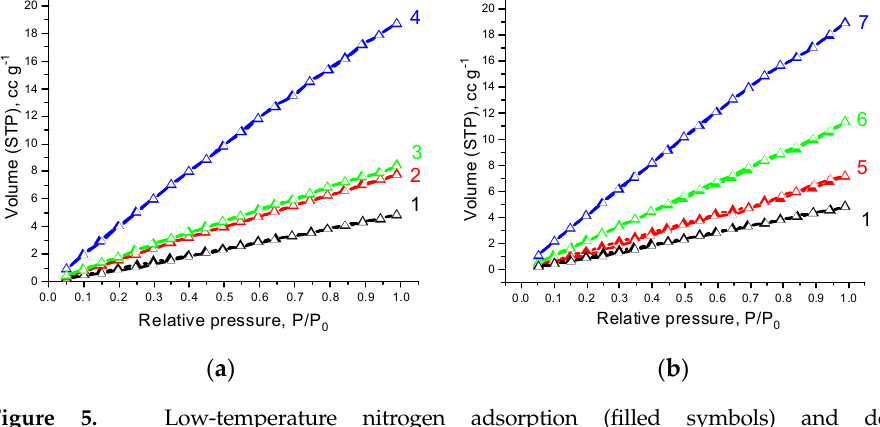
Figure 5. Low-temperature nitrogen adsorption (filled symbols) and desorption (open symbols) isotherms on the samples: 1—PHBV/PCL(1:1), 2—PHBV/PCL(1:1)/CNC(PVP)–5,